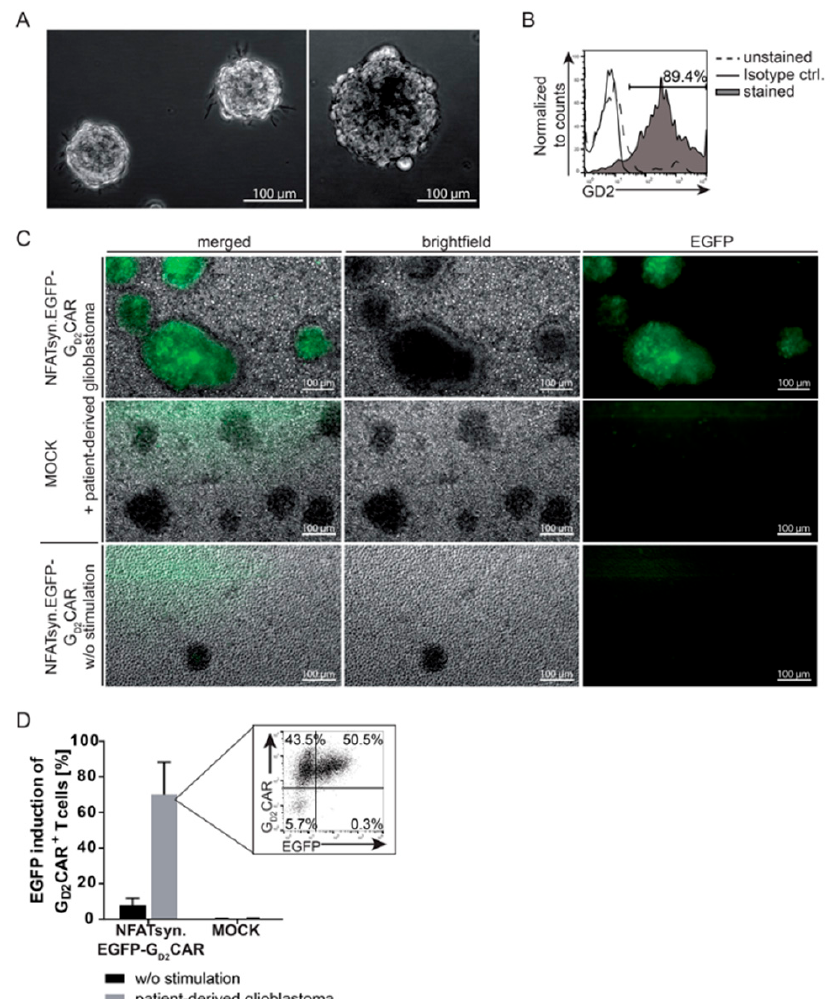
Figure 4. Specific induction of the NFATsyn promoter after CAR-specific activation with patient-derived primary glioblastoma cells. ( A ) Brightfield microscopy images of primary glioblastoma spheroids. ( B ) Expression of G D2 in primary glioblastoma cells analyzed via flow cytometric staining compared with isotype control (ctrl.) (representative patient sample). ( C–D ) Primary T cells from two independent donors were transduced with “all-in-one” NFATsyn.EGFP-G D2 CAR construct and co- cultured with or without patient-derived glioblastoma cells for 24 h. MOCK represents non- transduced T cells. ( C ) Representative images of NFATsyn.EGFP-G D2 CAR T cell co-culture experiments. The specific NFAT-driven EGFP upregulation after stimulation with patient-derived glioblastoma cells is shown in green. ( D ) Graph summarizes inducible NFAT-driven EGFP expression in “all-in-one” construct-positive (G D2 CAR + ) T cells post stimulation with GD2 + target cells and a representative flow cytometric analysis in transduced T cells after 24 h is depicted. Shown are mean values ± SD; symbols indicate individual co-culture experiments with individual donors; n = 2.